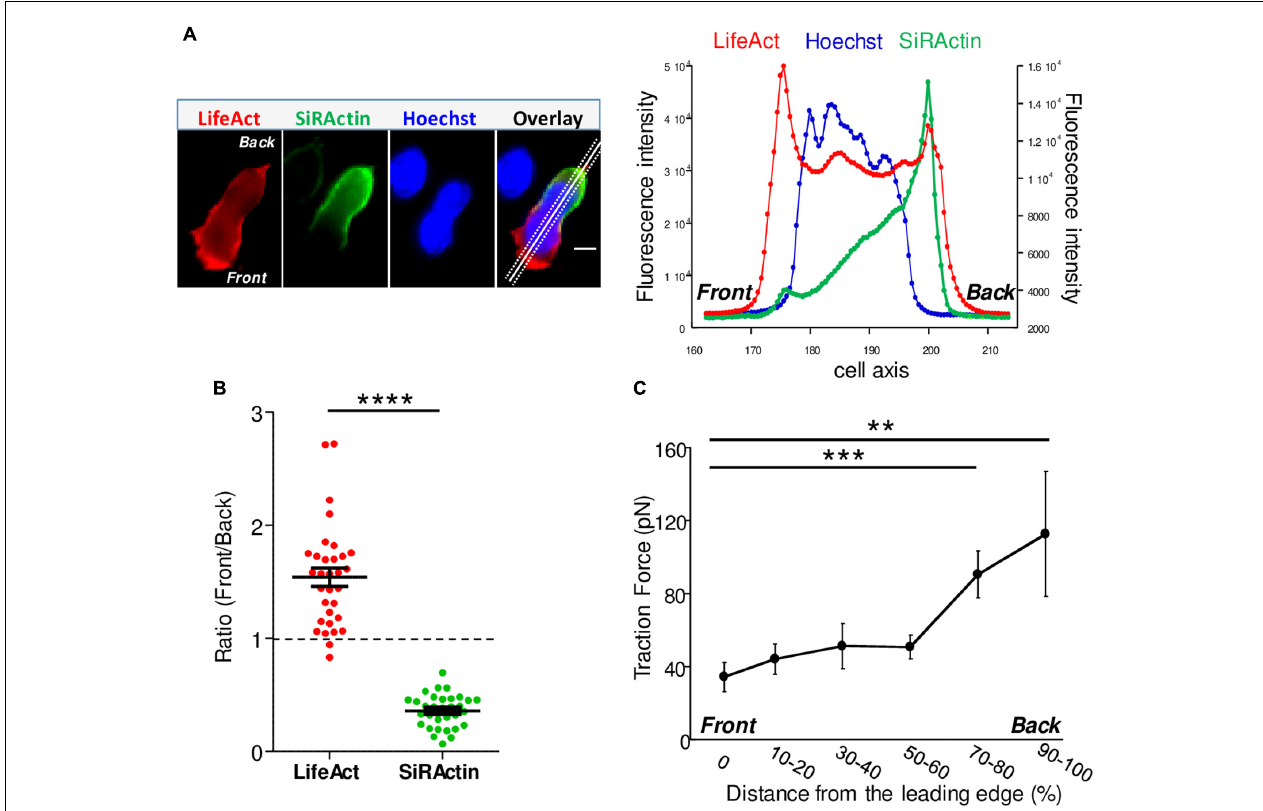
FIGURE 1 | Actin cytoskeleton asymmetry upon chemokine-stimulated T cells. (A) T cells were transfected with LifeAct-mCherry and labeled with SiRActin and Hoechst. After washing, the cells were deposited on a VCAM-1/CXCL12 coated coverslip. A typical distribution of total polymerized actin (LifeAct), stable actin network (SiRActin) and nucleus (Hoechst) is shown on the left panel and quantified along the scanline displayed on the overlay image (right panel). Images are from Movie 2. Scale bar = 10 µ m. (B) Using similar scanlines as in A, the ratio between front and rear intensities was measured for total polymerized actin and stable actin networks. Mean ± SE ( N = 31). The values obtained were statistically different (paired t -test, **** p < 0.0001, N = 32 cells). (C) The subcellular distribution of forces was measured in CXCL12-stimulated T cells upon migration on approximately 700 Pa gels coated with VCAM-1. The magnitude of these forces was significantly higher at the back of the cells compared to the front. The values of the forces expressed in picoNewton correspond to the mean of forces ± SE measured in 14 different cells. *** p < 0.001, ** p < 0.01 Kruskal-Wallis